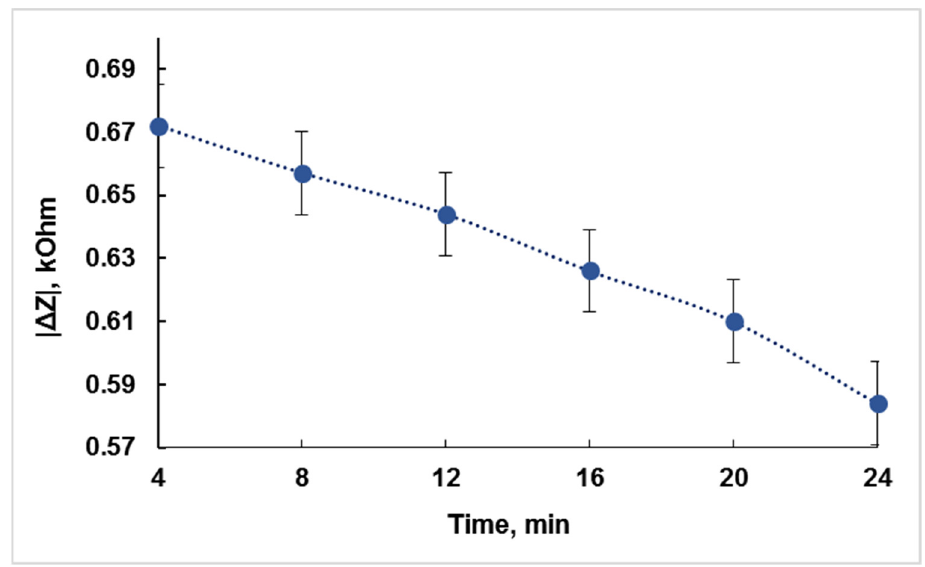
Figure 8. The dependence of the change in the absolute value of the electrical impedance modulus | Δ Z | on the time of the CAP exposure to E. coli K-12 cells at a frequency of 6.65